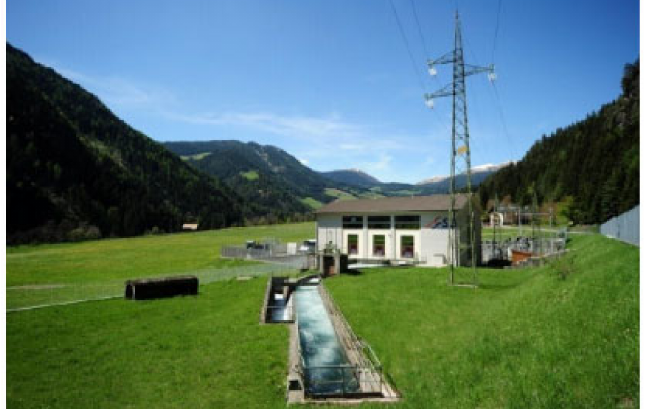
Figure 2. Hydroelectric power plant.